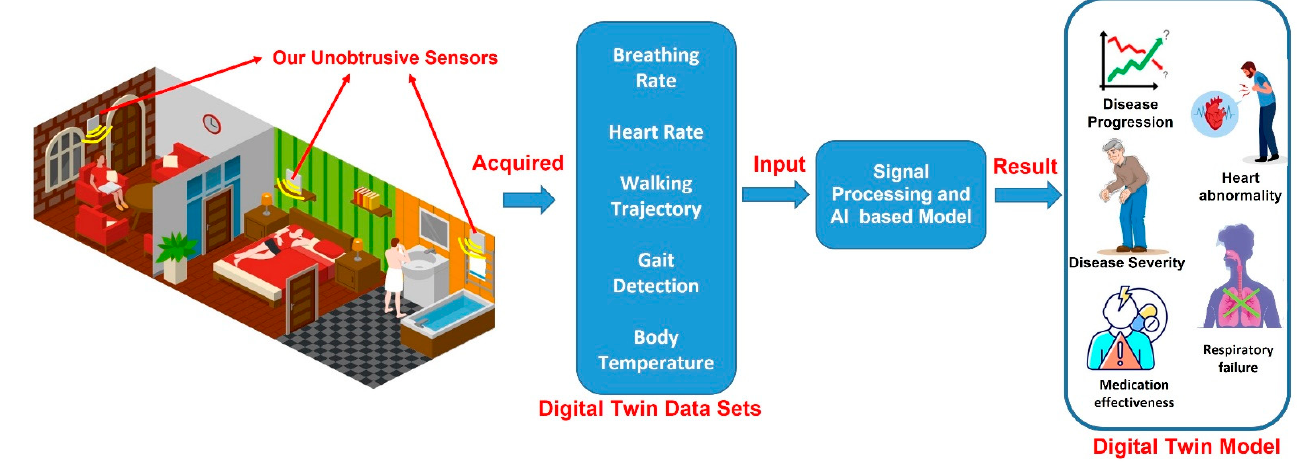
Figure 2. Proposed framework for creating DT model through the DT data sets collected through unobtrusive microwave sensors.